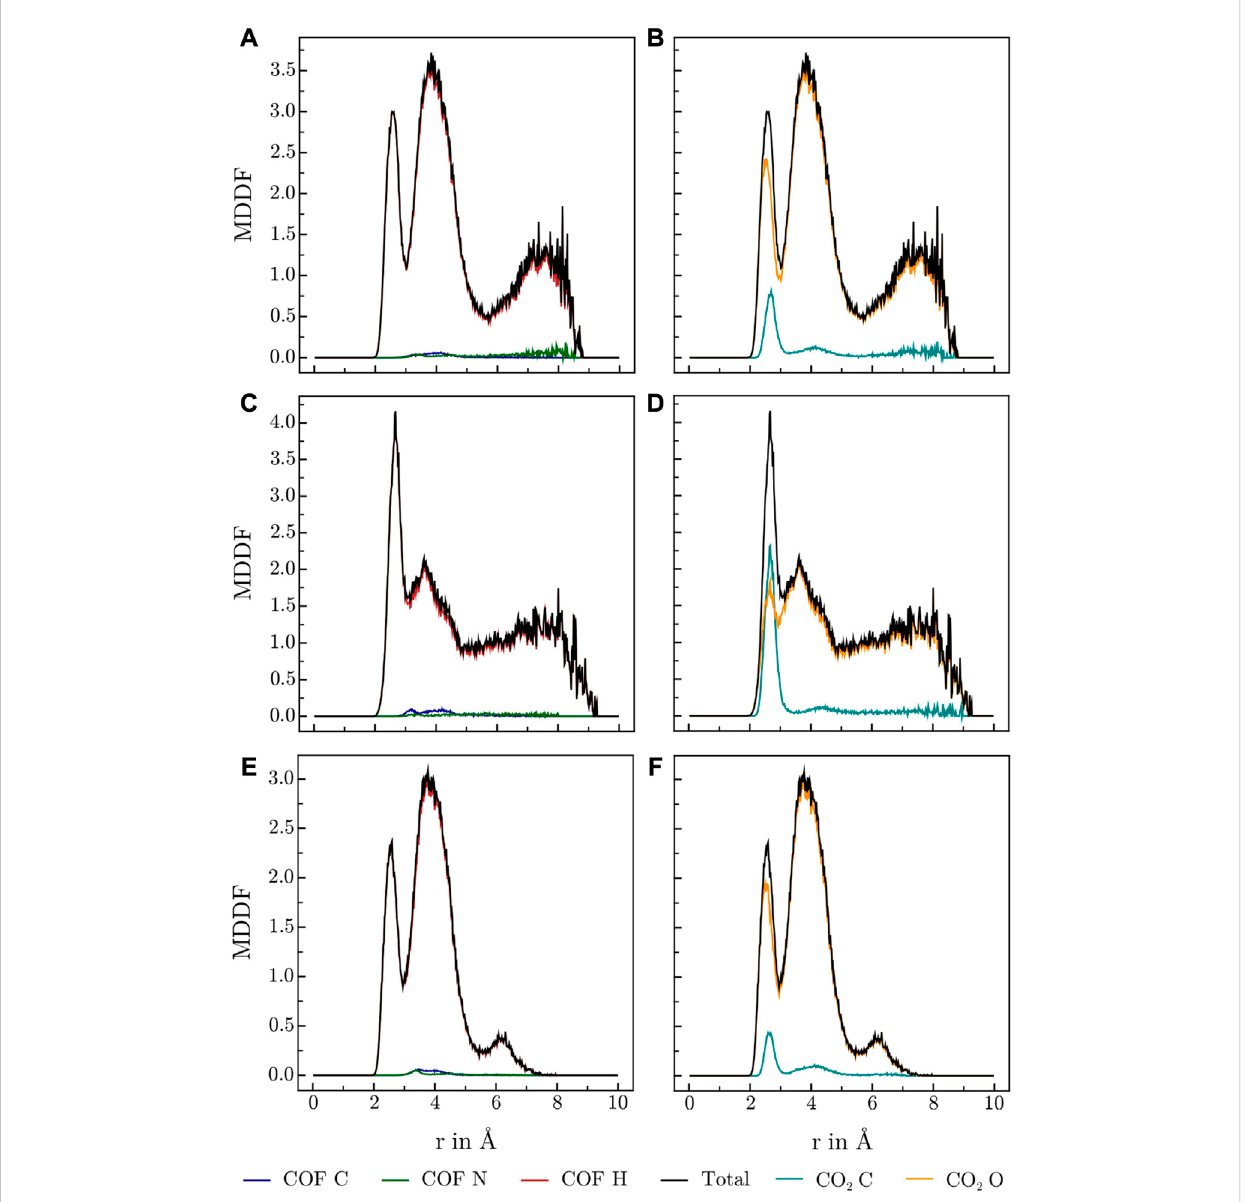
FIGURE 4 MDDFs obtained for 3D-HNU5 at various conditions, (A, B) 273.15 K and high CO 2 concentrations (16 CO 2 ), (C, D) 273.15 K and low CO 2 concentrations (4